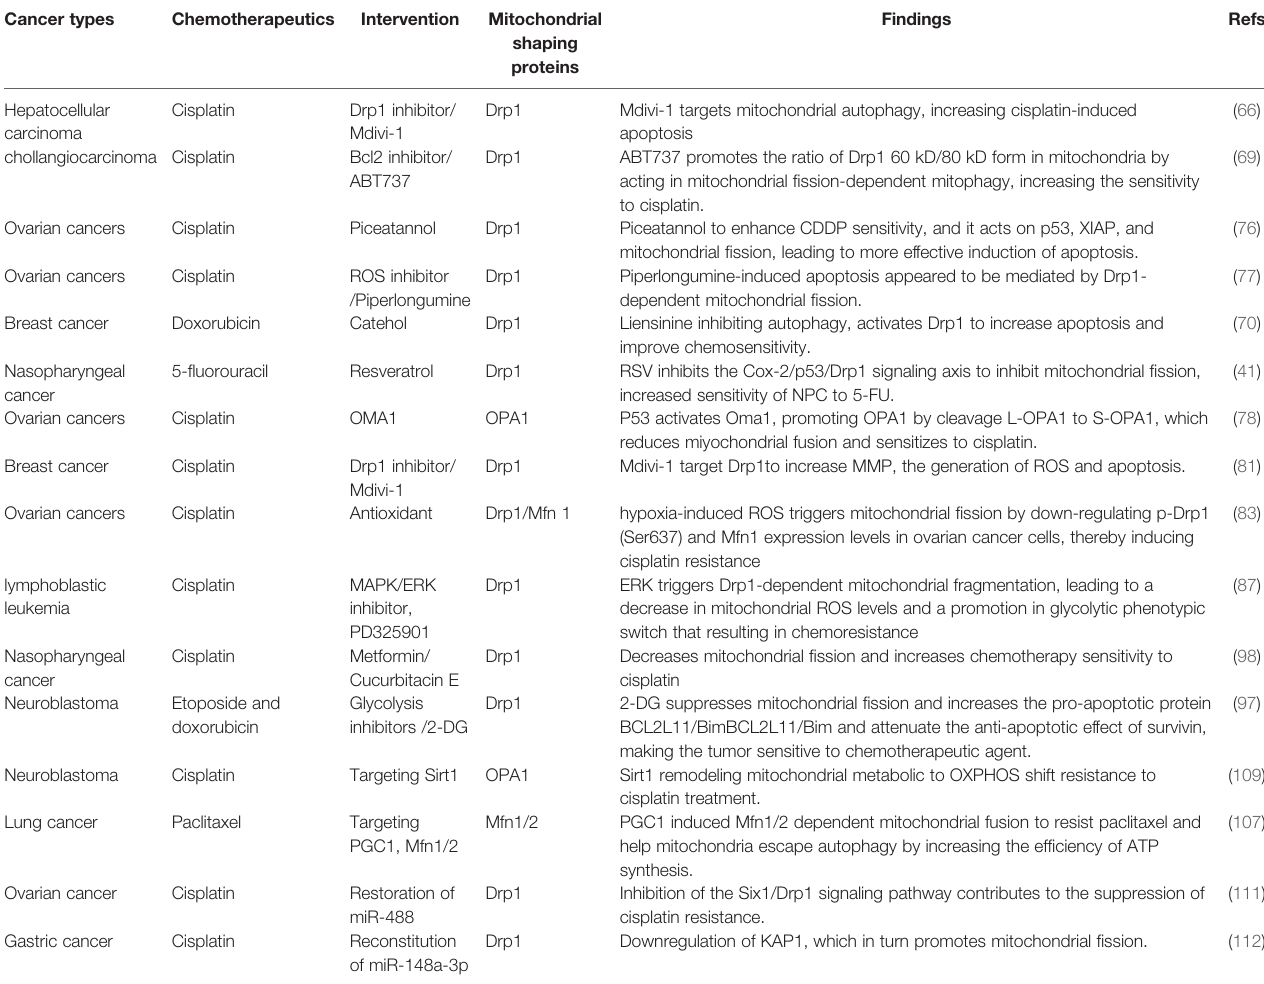
TABLE 2 | Summary of targeted mitochondrial dynamics synergistic